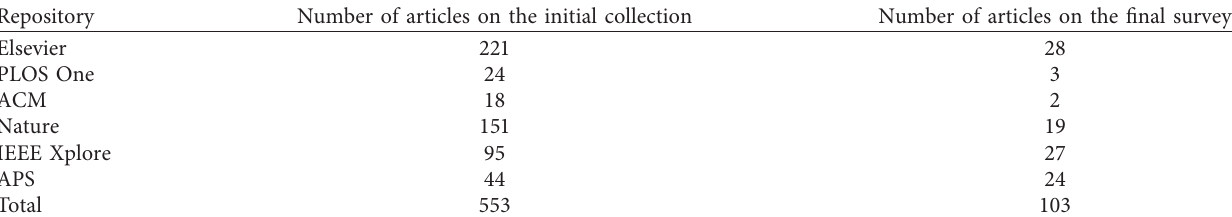
Table 1: Number of papers by repository and stage.